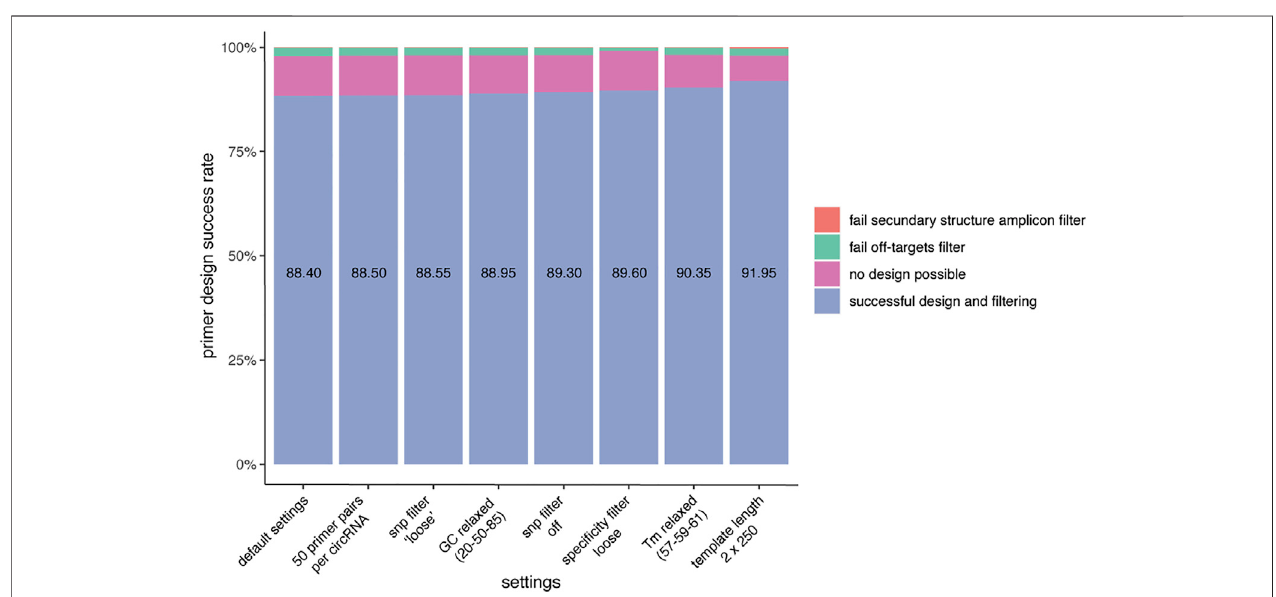
FIGURE 3 | CIRCprimerXL has a high primer design success rate. When using default settings, CIRCprimerXL has a primer design success rate of almost 90% (heretestedfor2000circRNAs).ThiscanbeincreasedbyoptimizingtheCIRCprimerXLparameters.Themostimprovementcanbeachievedbyallowingalargerdesign space (template length of 500 instead of